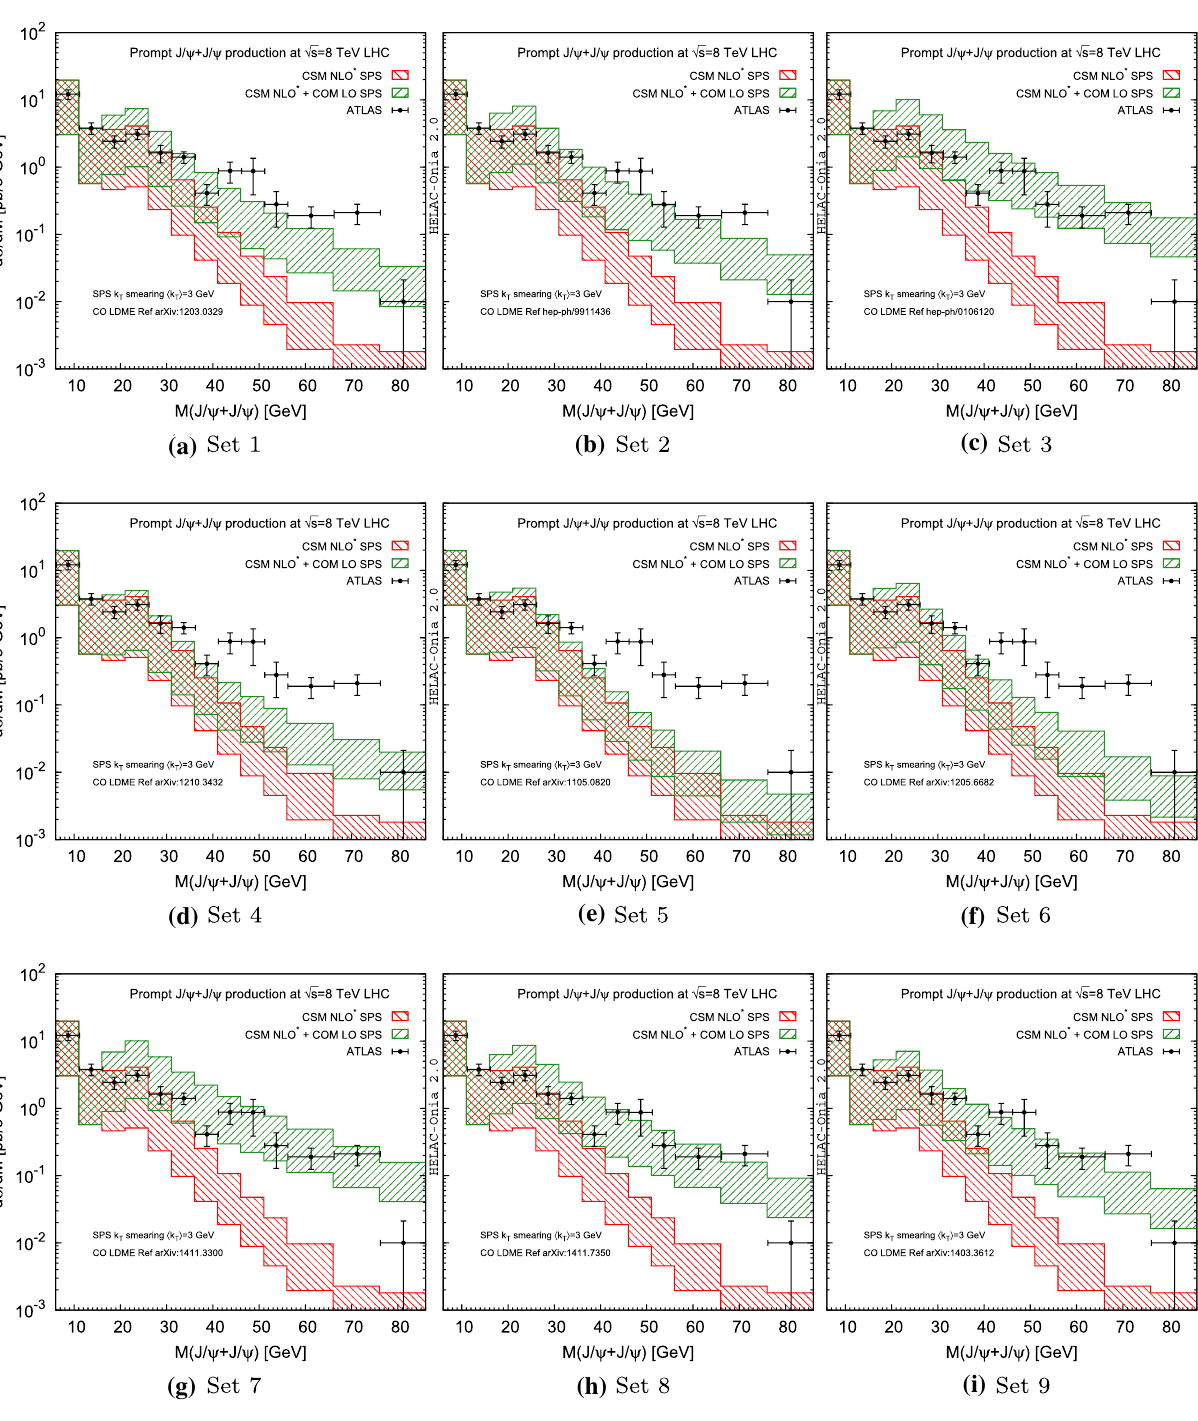
Fig. 9 M ( J /ψ, J /ψ) distributions in NLO (cid:11) CS and LO CO via SPS within ATLAS icantly reduce the CO fraction at large | Δ y ( J /ψ, J /ψ) |